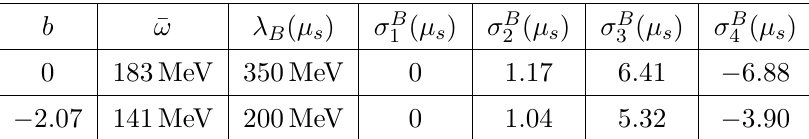
, which can be varied to obtain different shapes 0 ( ω, µ ) ∝ ω for ω → 0 and φ B s +